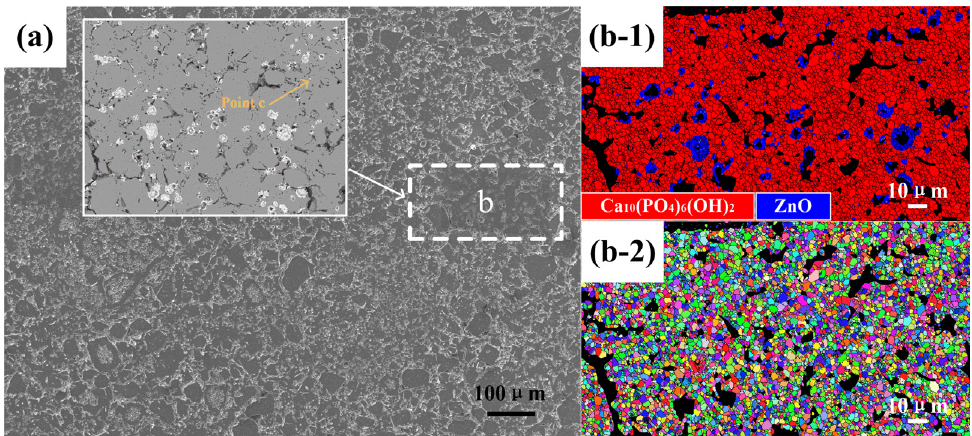
Figure 5. ( a ) SEM morphology; ( b-1 ) phase distribution; and ( b-2 ) inverse pole figures of ZnO / HA composite sample with 10% Zn addition sintered at 1250 ◦ C.